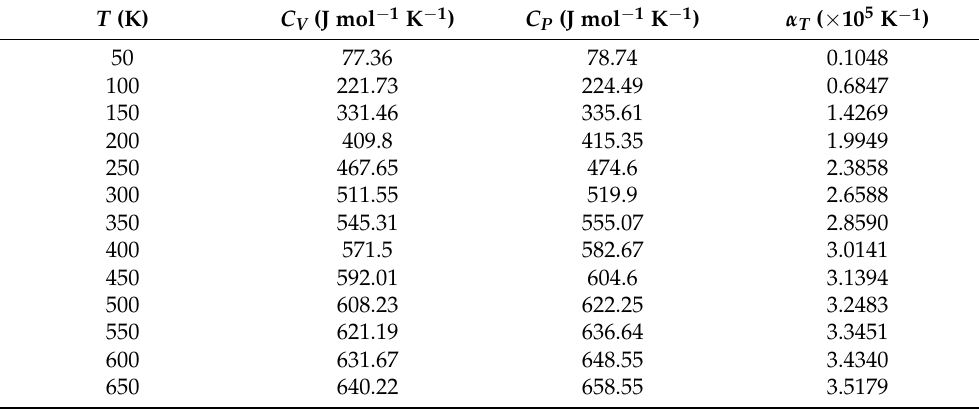
Table 5. Thermal expansion coefficient ( × 10 5 K − 1 ), and heat capacity (J mol − 1 K − 1 ) of Ca 7 MgSi 4 O 16 - Bre at selected T